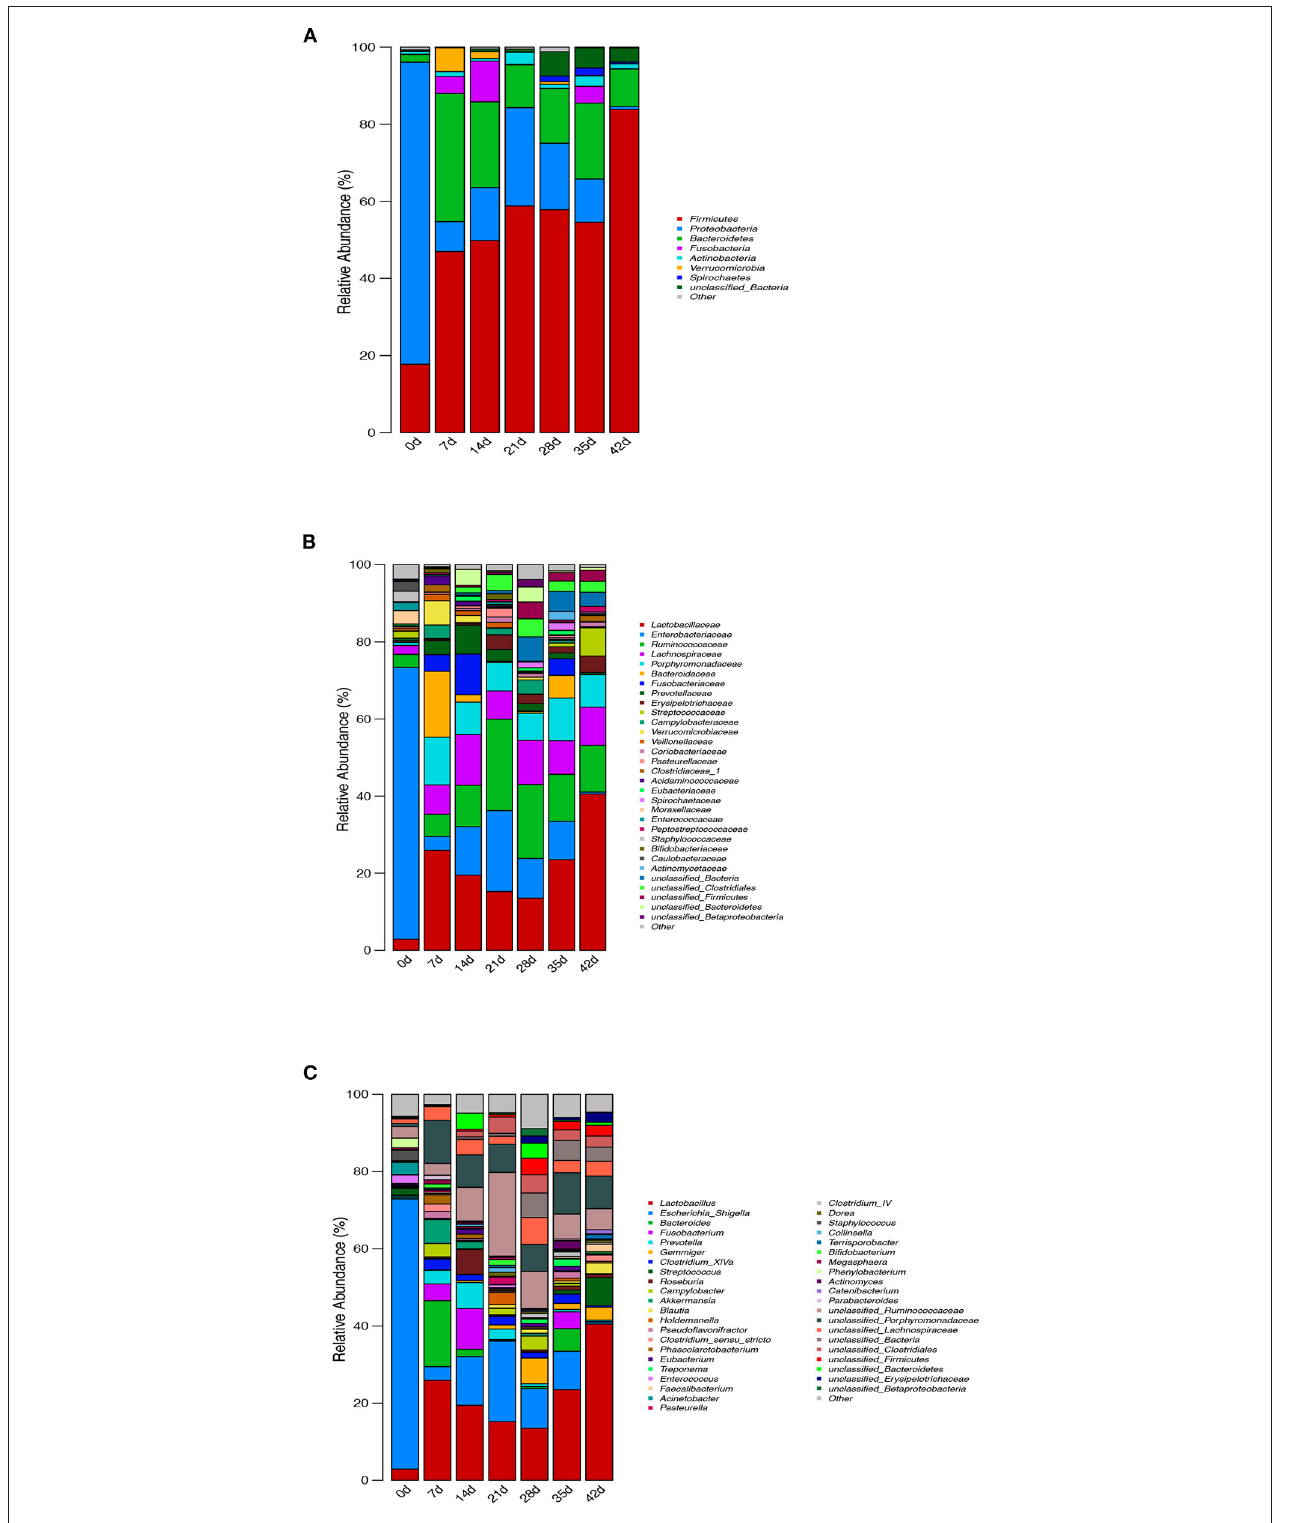
FIGURE 6 | Effect of piglets’ age on taxonomic classification of the 16S rRNA gene sequences at (A) phylum, (B) family, and (C) genus levels.